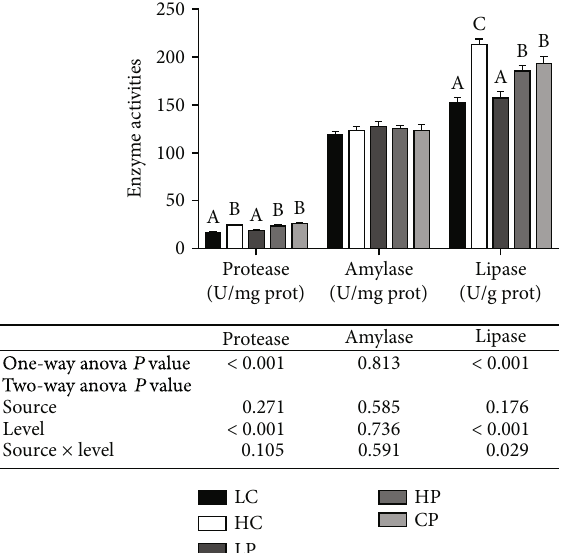
Figure 2: E ff ect of di ff erent sterol sources and levels on digestive enzyme activities in hepatopancreas of L. vannamei . Vertical bars represent the mean ± SEM ( n = 3 ). Data marked with di ff erent letters di ff er signi fi cantly ( P < 0 : 05 ) among groups based on Duncan ’ s test. The lack of superscript letter indicates no signi fi cant di ff erences among treatments. Two-way ANOVA followed by Student-Newman-Keuls (SNK) multiple comparison test was conducted to investigate the interaction e ff ects of sterol sources and